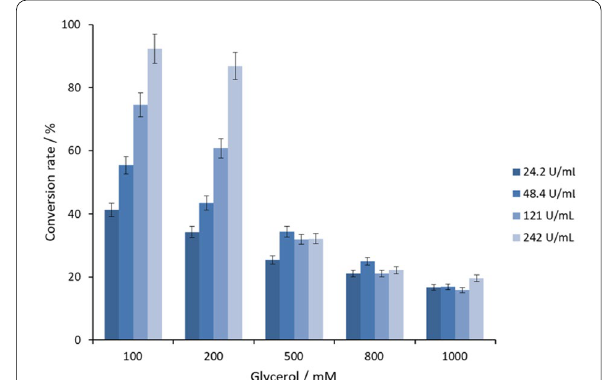
Fig. 5 The conversion rate of DHA using GldA-SpNox K184R coupled system. Legend means the amount of GldA added